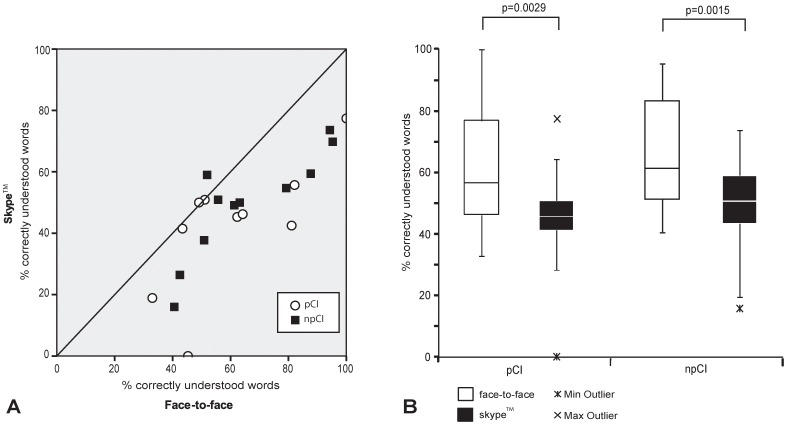
Speech reading capability of cochlear implant users.A. Comparison of speech perception scores in the absence of auditory input for n = 10 proficient (pCI) and n = 11 non-proficient (npCI) CI users for two visual communication modes (face-to-face without their implant activated vs. Skype™ video only). B. Boxplots showing speech reading scores for each condition and group.